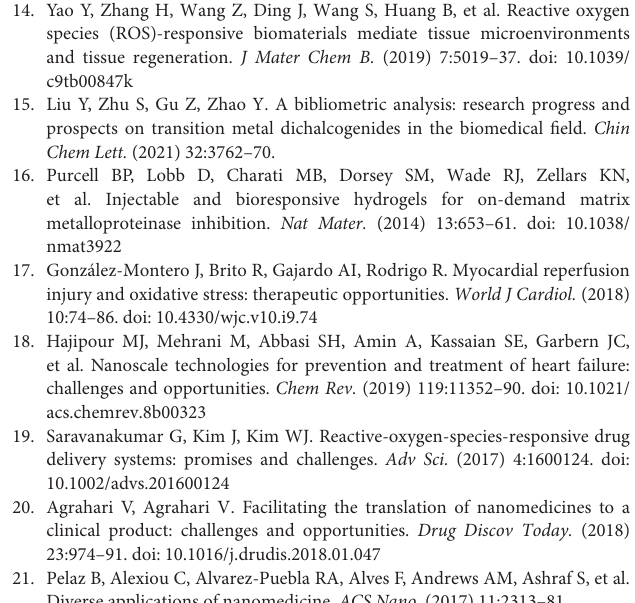
Supplementary Figure 1 | The retrieval strategy and results of publications. The search was conducted in the WoS core collection database on May 26th, 2022. Supplementary Table 1 | The 701 analyzed